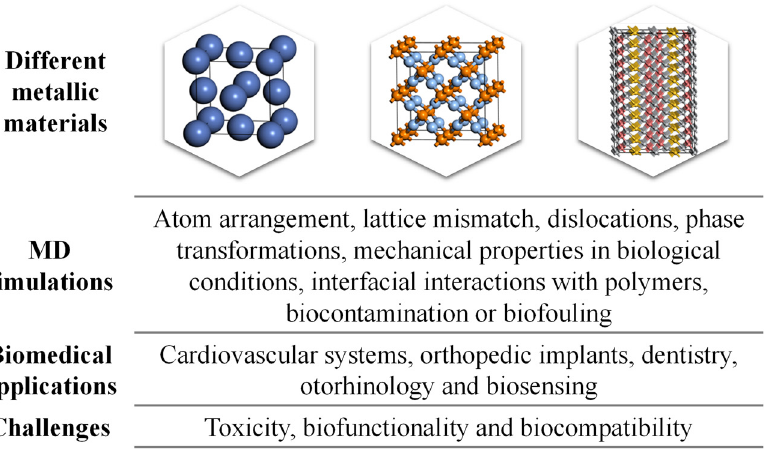
Figure 2: Nanoengineering of metallic materials using MD simulations, demonstrating general biomedical applications and concerned